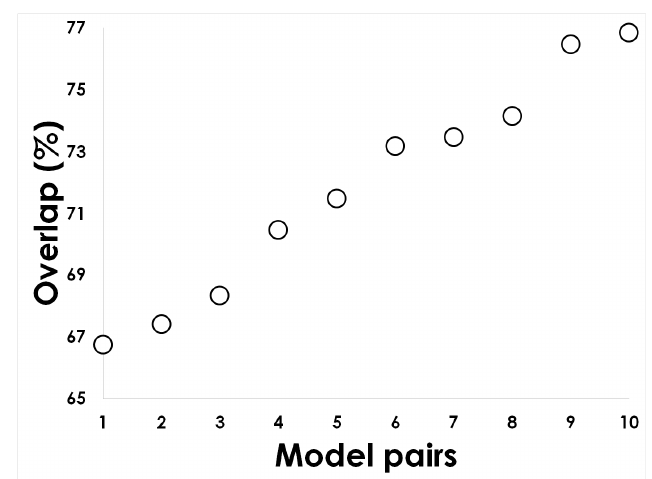
Figure 2. Classifiers combined scores. A circle represents each model; the best model has the lowest C Score . The line represents the CScore = 0.3, that separates the top 5 models from the rest. The models using heterologous data are represented as circles; triangles are used otherwise. The actual data of this plot can be found in Supplementary Table S20.